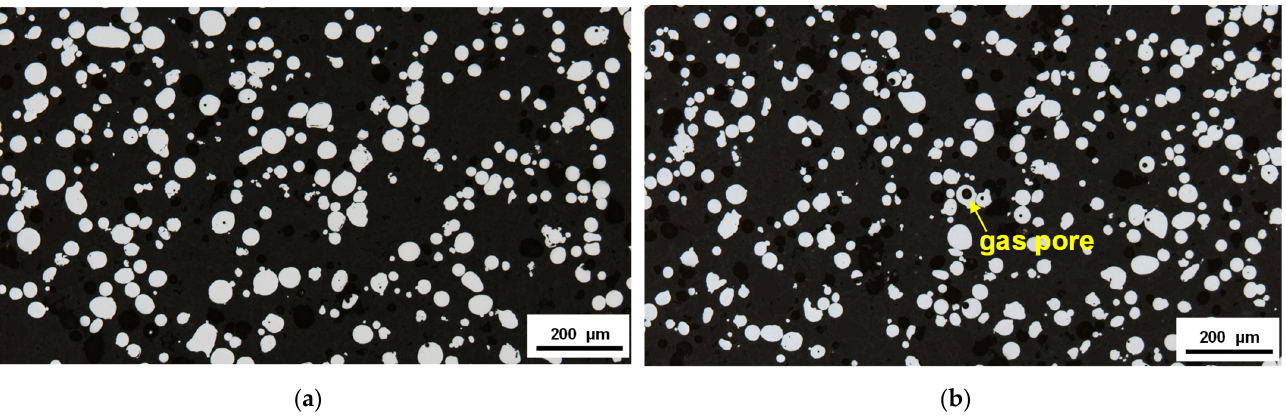
Figure 3. Light micrographs of polished cross ‐ sections of the initial powders: ( a ) X2CrNiMo17 ‐ 12 ‐ 2; ( b ) X2CrNiMoN25 ‐ 7 ‐ 4. The particle size distributions of the X2CrNiMo17 ‐ 12 ‐ 2 powder and the X2CrNi ‐ MoN25 ‐ 7 ‐ 4 powder are shown in Figure 4. The X2CrNiMo17 ‐ 12 ‐ 2 powder shows a rela ‐ tively large particle size compared to the X2CrNiMoN25 ‐ 7 ‐ 4 powder. The median particle diameter d 50 of the X2CrNiMo17 ‐ 12 ‐ 2 powder and the X2CrNiMoN25 ‐ 7 ‐ 4 powder is about 43 μ m and 41 μ m, respectively. There are very few fine particles (smaller than the nominal lower fraction limit of 20 μ m) in the powders.